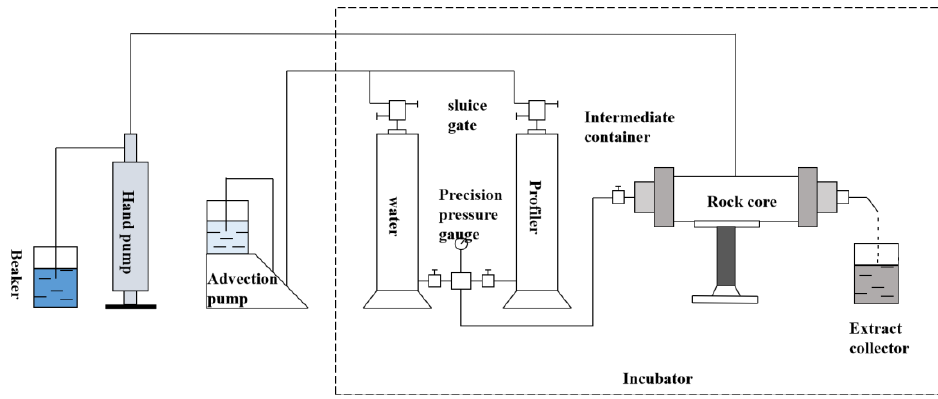
Figure 1. Flow chart of experimental equipment. (Note: Except for the advection pump, hand shaking pump and nitrogen bottle, other parts are placed in the 65 °C electric constant temperature oven.).